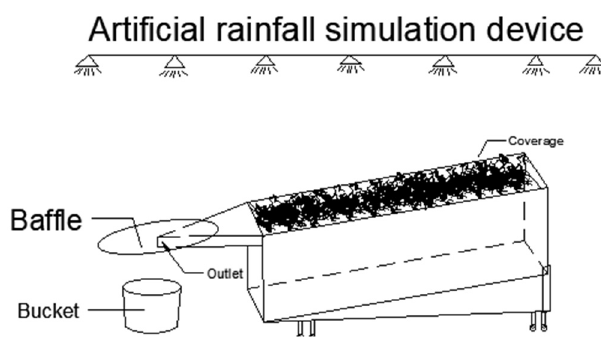
Figure 1. Artificial simulation rainfall experiment. Table 1. Litter characteristics of Pinus massoniana.